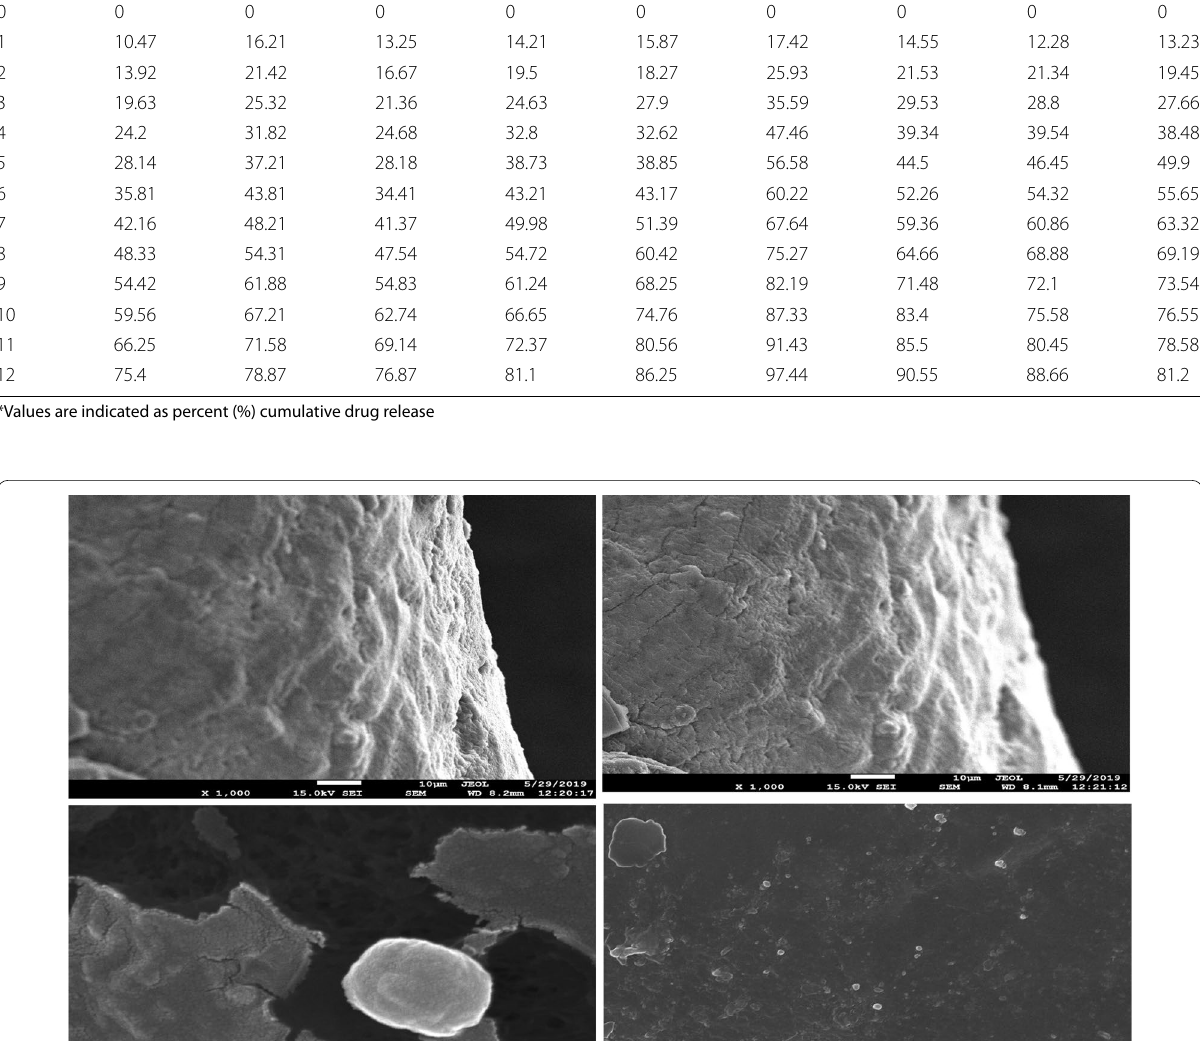
Table 5 In vitro drug release study of the 9 batches of microspheres